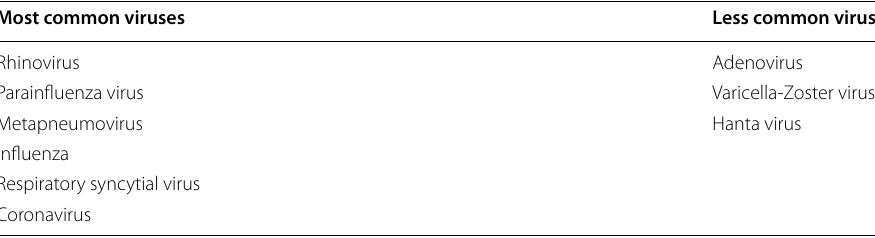
Table 1 Viral causes of severe